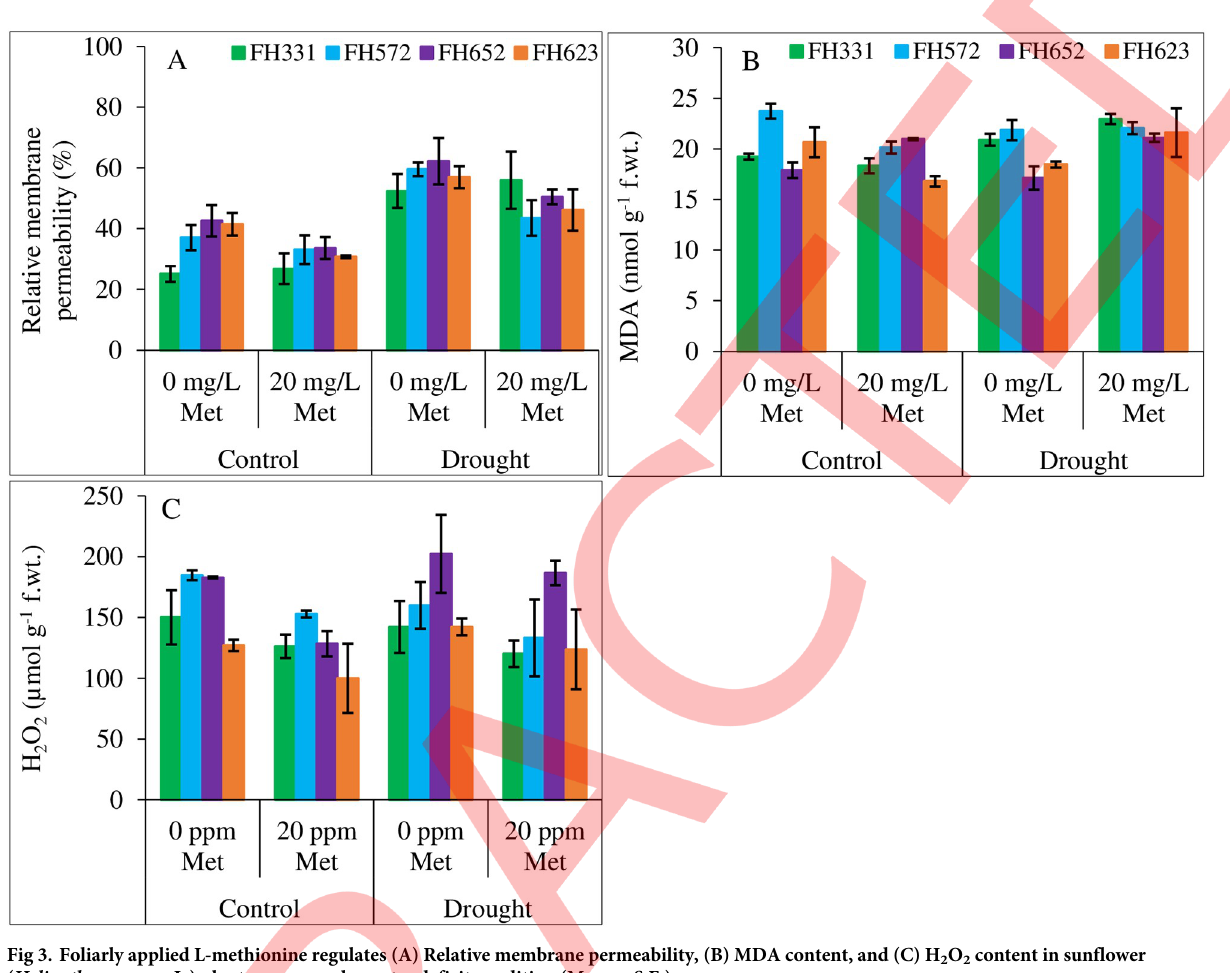
Fig 3. Foliarly applied L-methionine regulates (A) Relative membrane permeability, (B) MDA content, and (C) H 2 O 2 content in sunflower ( Helianthus annuus L.) plants grown under water deficit condition (Mean ± S.E.).